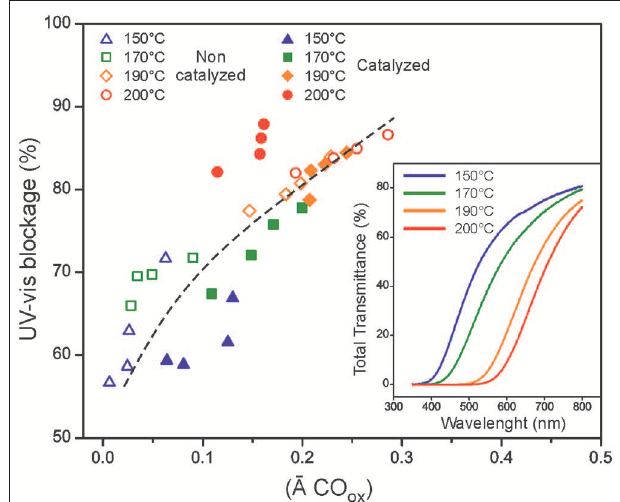
FIGURE 9 | Relationship between the UV-vis blockage and the presence of oxidized species at the air exposed side of films. The inset shows the total transmittance UV-vis curves of polyaleuritates prepared in air for 16h at the indicated